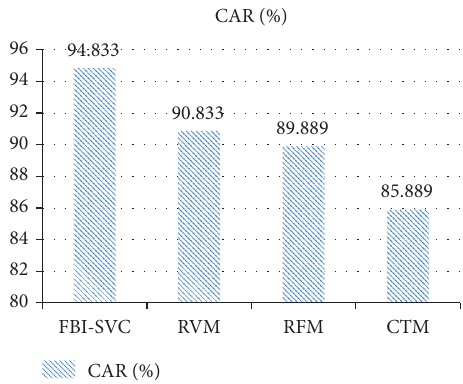
Figure 9: Performance comparison with respect to the CAR.